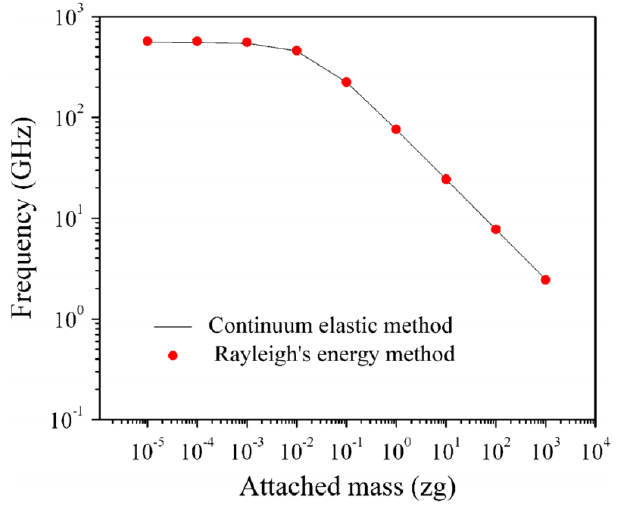
Figure 8. Comparison of the resonant frequency between the Euler–Bernoulli beam model and the Raleigh’s energy method. Adapted with permission from [42], Copyright Springer, 2014.